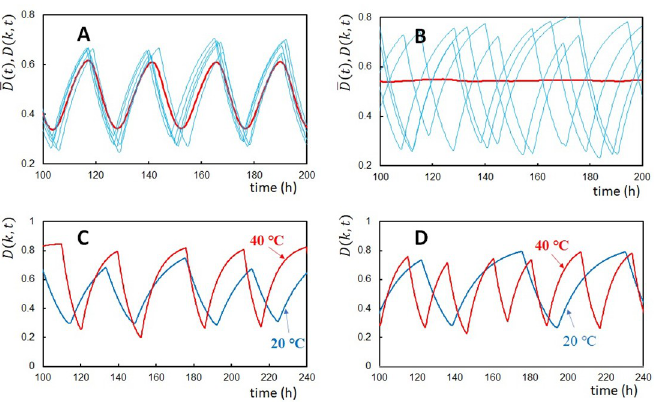
Fig 9. Temperature compensation of oscillations of individual molecules. In A and B , oscillations of the ensemble- averaged phosphorylation level � D ð t Þ (red) are compared with five individual oscillations D ( k , t ) of molecules arbitrarily chosen from the ensemble (blue). T = T 0 . ( A ) h AB was kept in the standard value (Table 2). ( B ) h AB was reduced to 1/20 of the standard value. ( C ) Oscillations of D ( k , t ) of an arbitrarily chosen single molecule at T = 40˚C (red) and T = 20˚C (blue). Three rules, Rule 1 (thermal attenuation of the reaction-structure feedback coupling with Δ E f = 6 k B T ), Rule 2 (thermal activation of KaiB transformation), and Rule 3 (temperature insensitivity of the ATPase reactions), were assumed. ( D ) Oscillations of D ( k , t ) of an arbitrarily chosen single molecule at T = 40˚C (red) and T = 20˚C (blue). Rule 2 and Rule 3 were assumed, while Rule 1 was not adopted with Δ E f = 0. In C and D , h AB was reduced to 1/20 of the standard value. N =